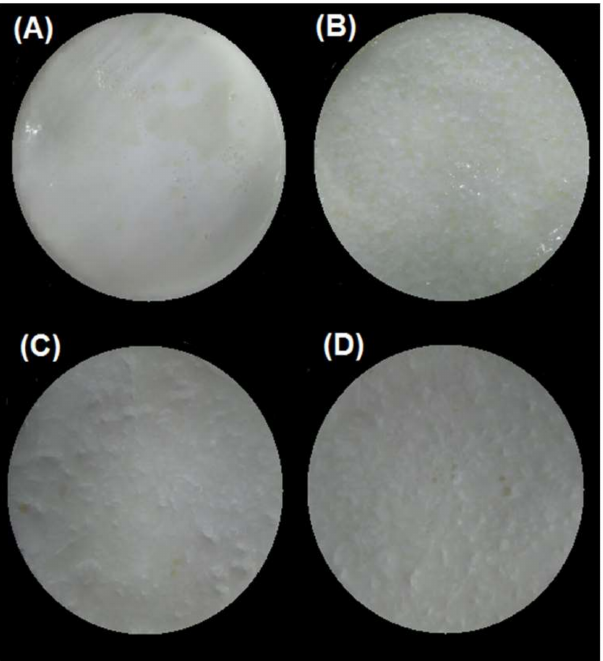
Figure 5. Images of the chyme obtained after in vitro gastric digestion in the SBg system of the different emulsion gels stabilized by WPI. ( A ) pH 4/500 bar, ( B ) pH 4/1000 bar, ( C ) pH 7/500 bar, and ( D ) pH 7/1000